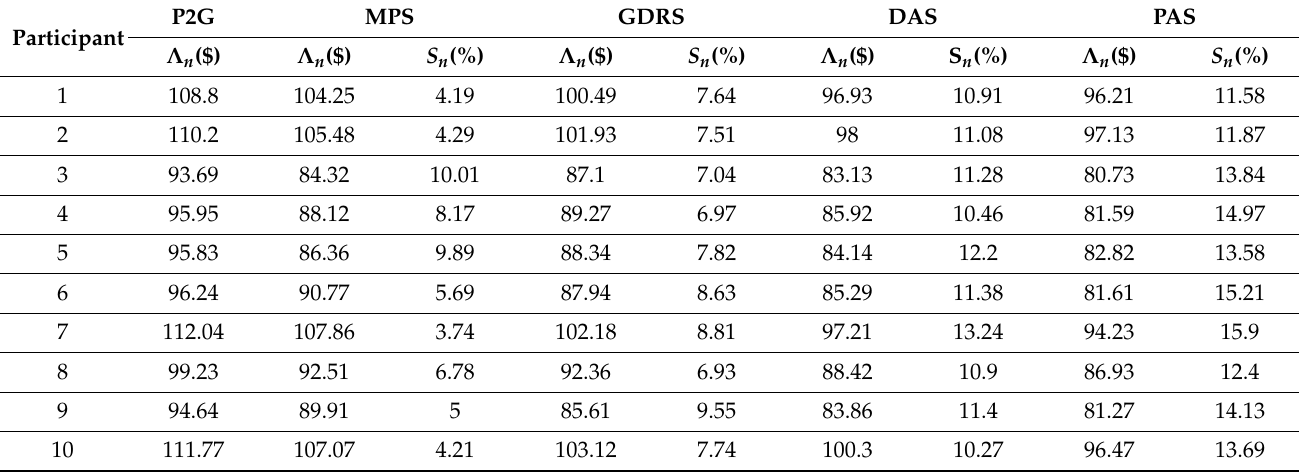
Table 2. Participants’ monthly electricity bill.